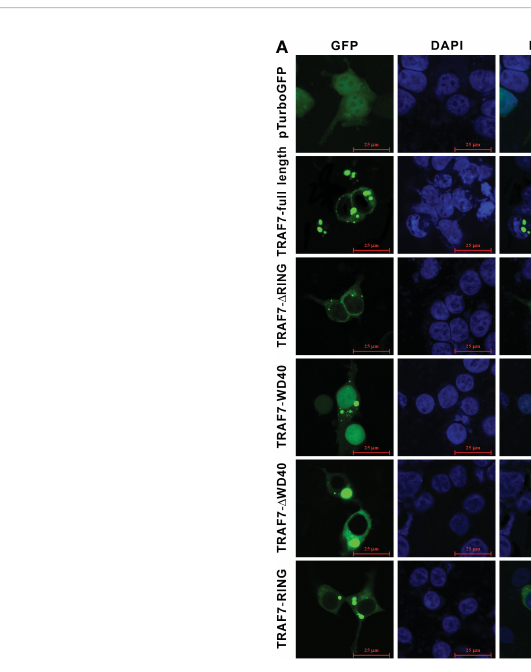
FIGURE 7 Subcellular localization of Lc -TRAF7 and its truncated forms. (A) HEK 293T cells were transfected with pTurboGFP-N (vector control), pTurbo-TRAF7- GFP, pTurbo-TRAF7- D RING-GFP, pTurbo-TRAF7-WD40-GFP, pTurbo-TRAF7- D WD40-GFP, and pTurbo-TRAF7-RING-GFP, respectively. At 24 hpt, the cells were stained with DAPI, followed by detecting under a confocal microscope and photographed. (B) The con fi rmation of the expression of GFP fusion proteins including the pTurboGFP, the full-length TRAF7, TRAF7- D RING, TRAF7-WD40, TRAF7- D WD40, and TRAF7-RING was conducted by Western blotting analysis using the Anti-TurboGFP antibody.